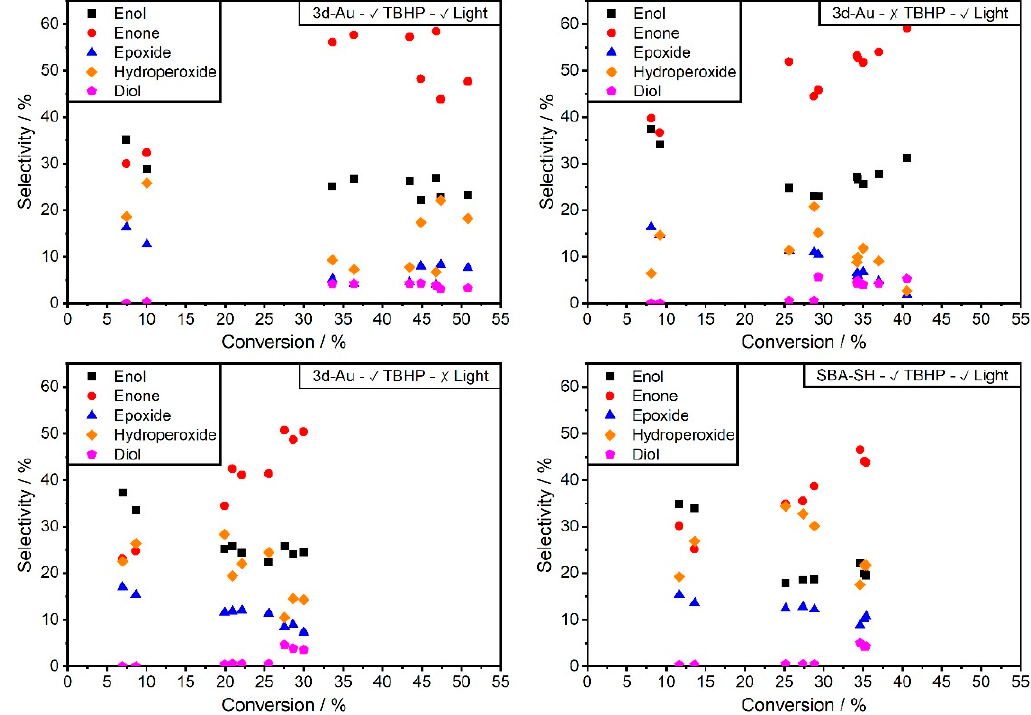
Figure 10. Selectivity to the different reaction products for catalyst 3d-Au for the reactions displayed in Figure 9.